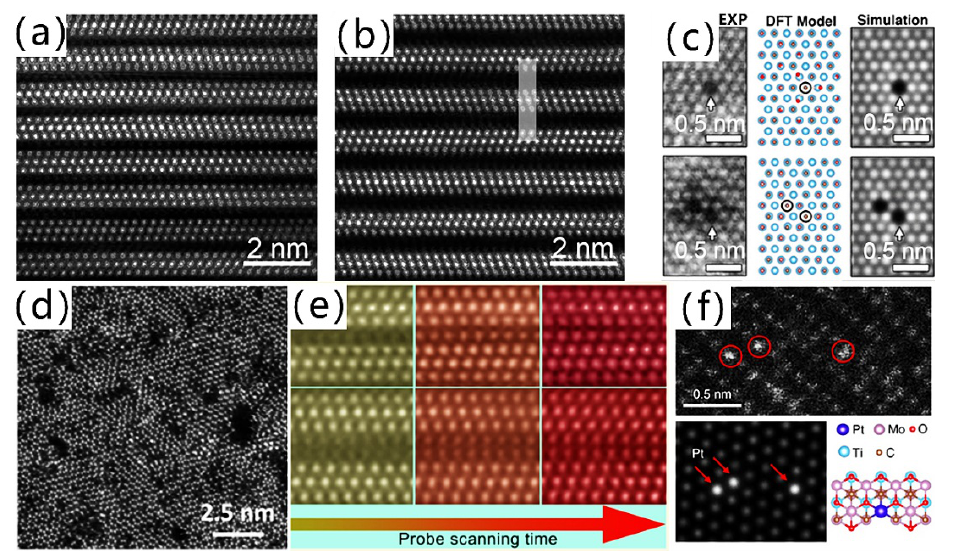
Fig. 17 Atomic structures of MXene in STEM. STEM images of (a) Ti 3 C 2 T x and (b) annealed Ti 3 C 2 T x in ammonia along the [112¯0] zone axis. Reproduced with permission from Ref. [143], © Royal Society of Chemistry 2020. (c) Comparison between experimental HAADF-STEM image, defect crystal structure determined from density functional theory (DFT), and simulated HAADF-STEM image of V Ti (top) and two adjacent V Ti within the same sublayer (bottom). (d) STEM micrograph of a Nb 1.33 CT x single flake. Reproduced with permission from Ref. [151], © American Chemical Society 2018. (e) Atomic resolution HAADF-STEM images of one region in Ti 3 C 2 T x with the irradiation of electron probe. Reproduced with permission from Ref. [152], © American Chemical Society 2019. (f) Magnified HAADF-STEM image of Mo 2 TiC 2 T x –Pt SA and its corresponding simulated image, and illustration of the structure of Mo 2 TiC 2 T x –Pt SA showing the isolated Pt atoms. Reproduced with permission from Ref. [153], © The Author(s)